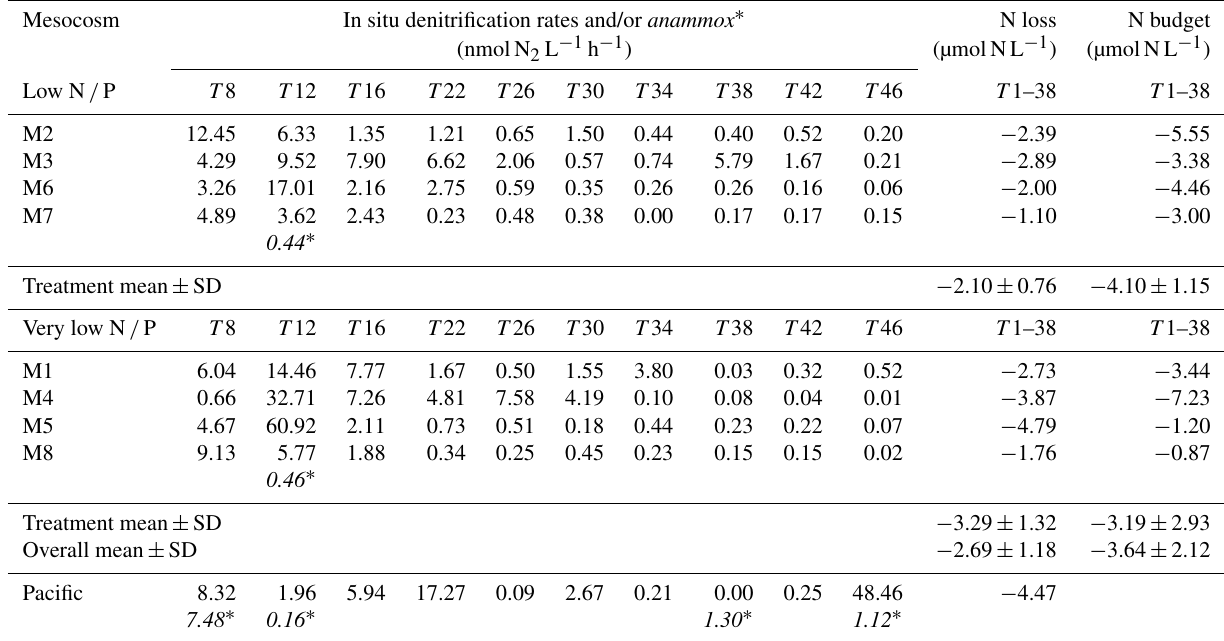
Table 2. Calculated in situ denitrification rates (nanomole dinotrogen per litre per hour; hereafter nmolN 2 L − 1 h − 1 ) in the low N / P and very low N / P deep water addition mesocosms and the surrounding Pacific (see Sect. 2.4 for details), together with those for